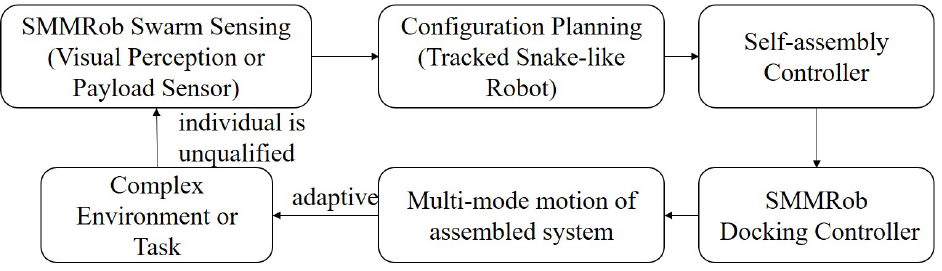
Figure 7. Overview of the control